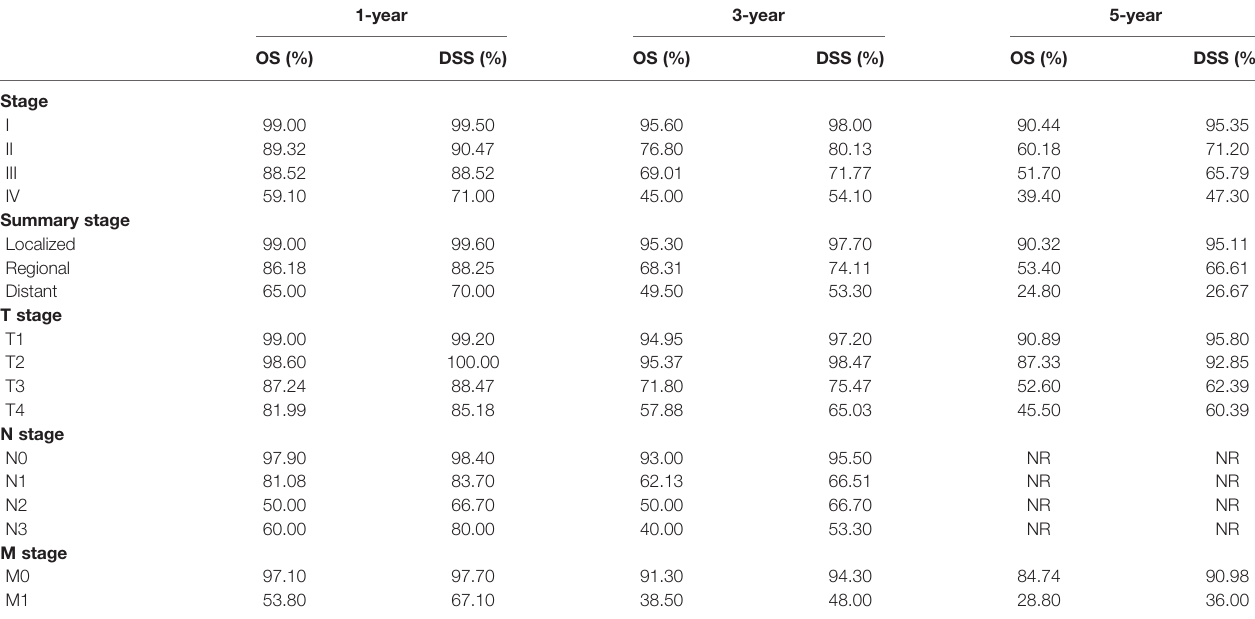
TABLE 3 | Summary of OS and DSS rates at years 1, 3, and 5 in patients with HIV-associated CTCL under different tumor staging